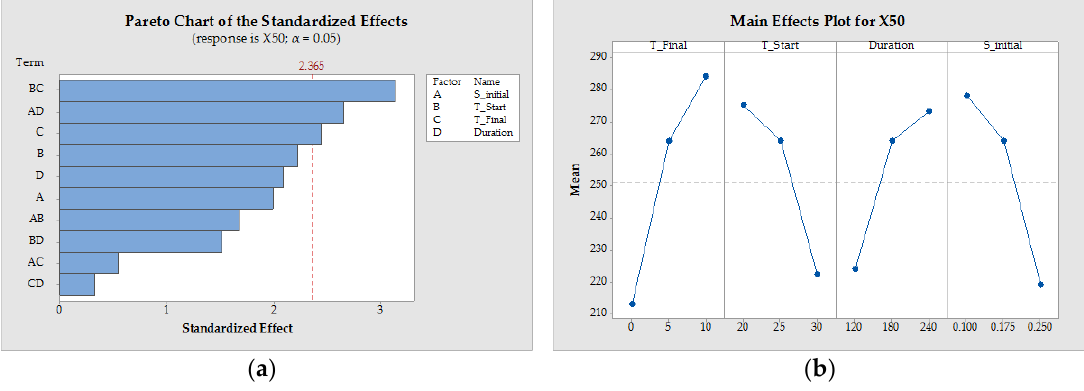
Figure 9. Influences on x 50 : ( a ) significances and ( b ) main effects.